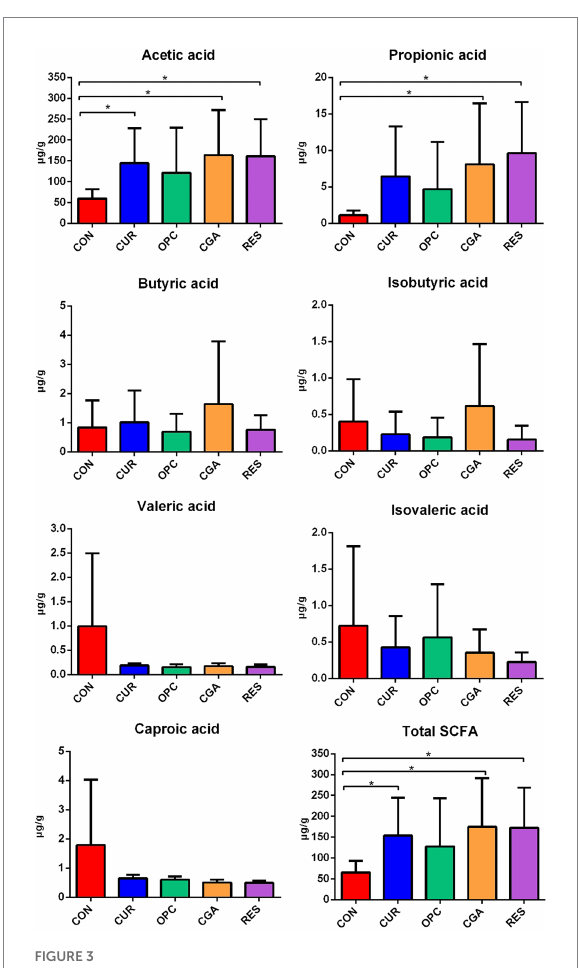
FIGURE 3 Effect of plant polyphenols on the concentration of short chain fatty acids ( n = 9 per treatment). Data are presented as mean ± standard deviation. Significant differences were labeled as * for p < 0.05. CON, control group; CUR, curcumin group; OPC, oligomeric proantho cyanidins group; CGA, chlorogenic acid group; RES, resveratrol